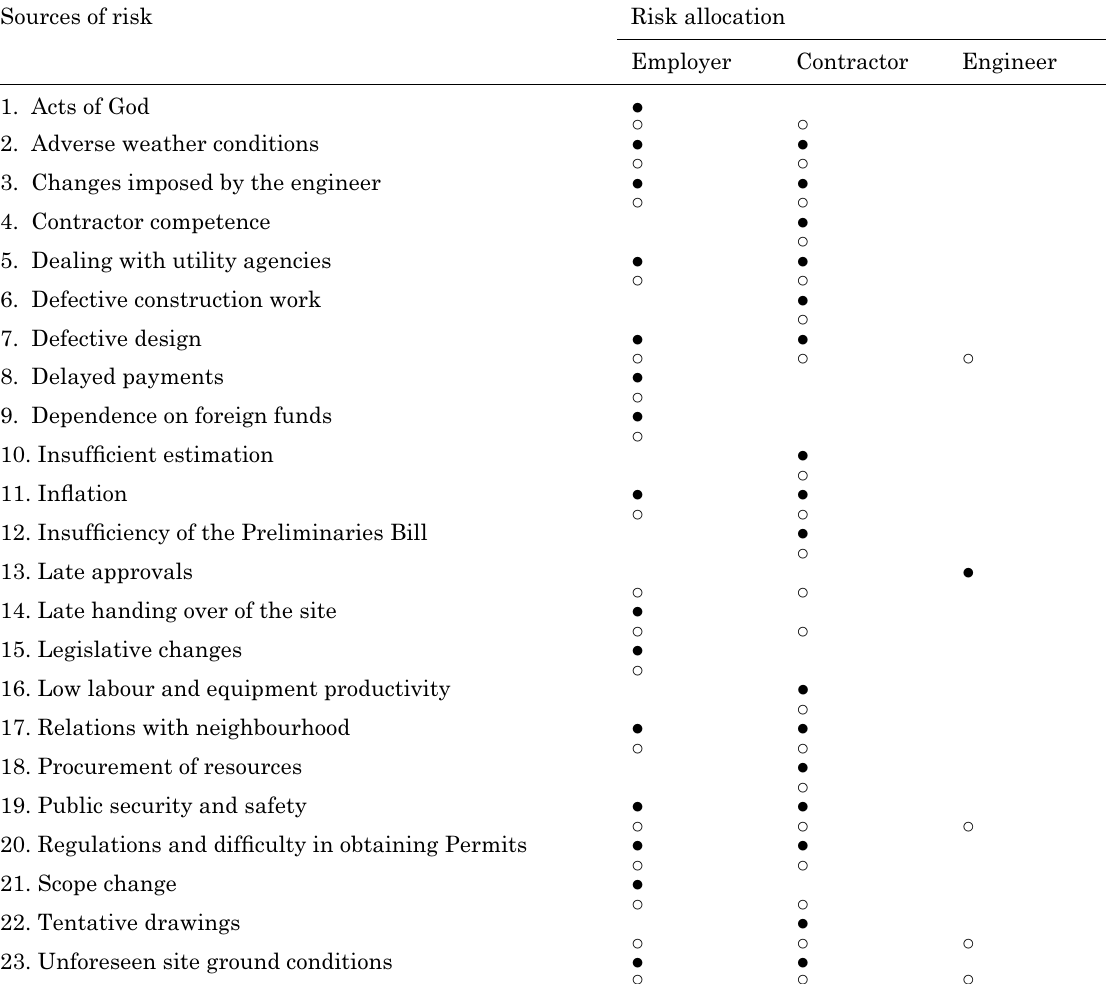
Table 2. Actual risk allocation vs. risk allocation through contract